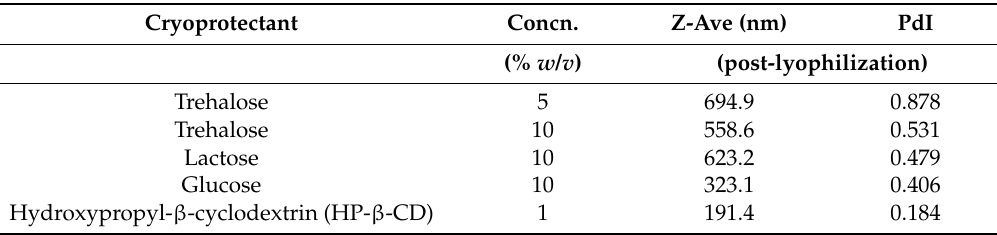
Table 4. Results of the freeze-drying and cryoprotection studies. The tested nanoparticle batches had a mean particle size of 158.1 nm before